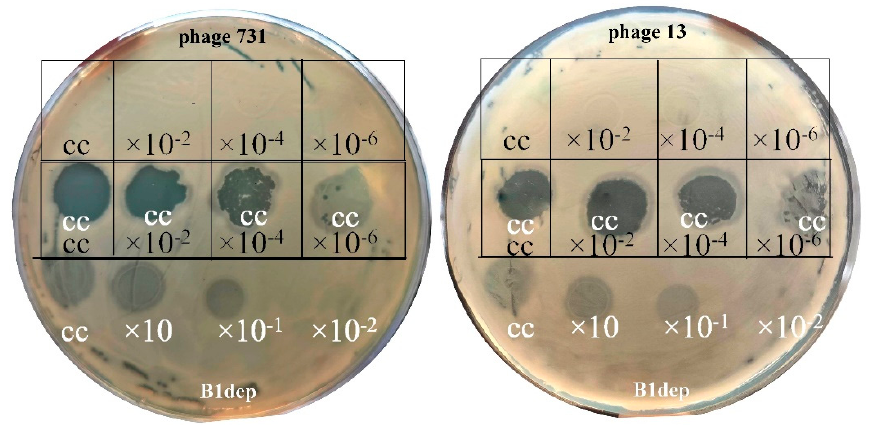
Figure 2. Synergistic effect of B1dep protein and phages 731 and 13 on 52145 lawn with the K2 capsule. Middle rows: 10 microliters of the purified recombinant B1dep protein was mixed and spotted along with 10-10 μ L-s of different titers of phage 731 ( left plate) or phage 13 ( right plate) suspensions. Phage control dilutions ( up ) and B1dep control with dilution ( bottom ) were also spotted and are presented. Clear zones (dark here) indicate full lysis of the bacteria by the phages; semi-translucent (light dark here) halo zones are produced by B1dep. Cc = concentrated phage suspension ( ≈ 10 9 PFU/mL, black text) or B1dep ( ≈ 800 ng, white text).